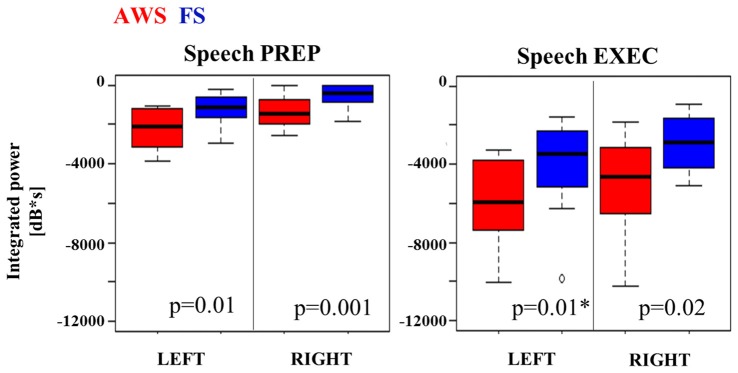
Integrated beta suppression during speech preparation (PREP) and execution (EXEC).
Note. AWS group showed stronger left beta suppression during speech execution once the outlier was removed (*).